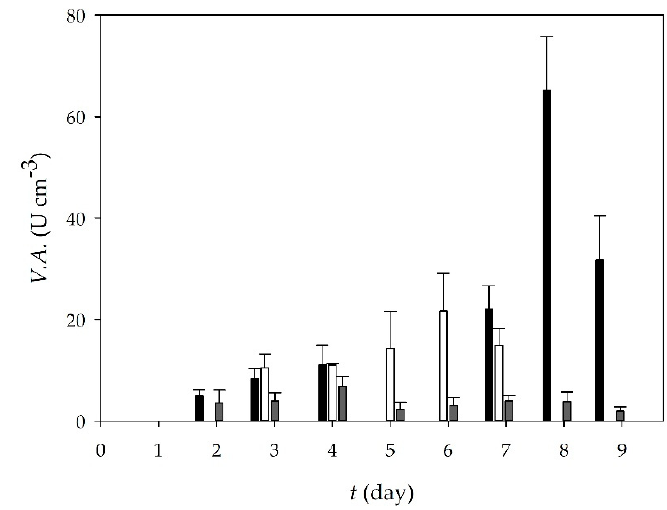
Figure 1. Lipase activities during T. lanuginosus cultivation on different oil cakes ( ■ hemp oil cake, □ flax oil cake, and ■ hull-less pumpkin oil cake).